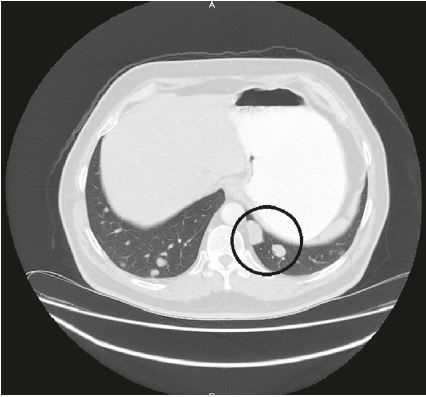
Figure 2: PET scan-correlated CT section of lung nodule at the diagnosis of BRAF-mutant